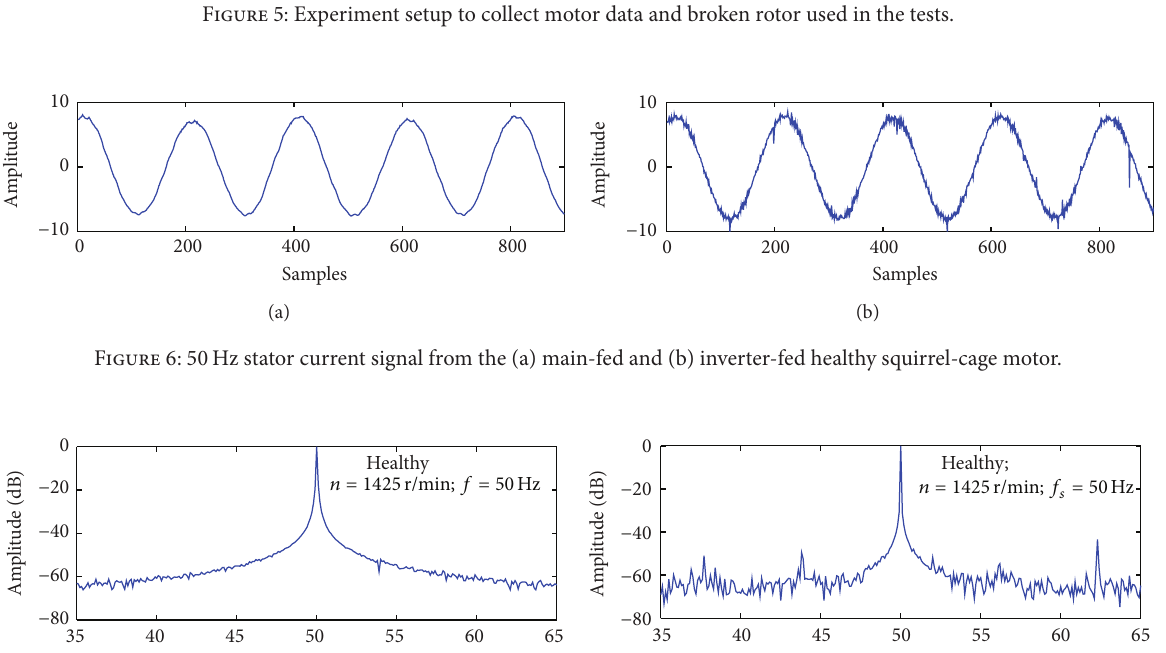
Figure 5: Experiment setup to collect motor data and broken rotor used in the tests.